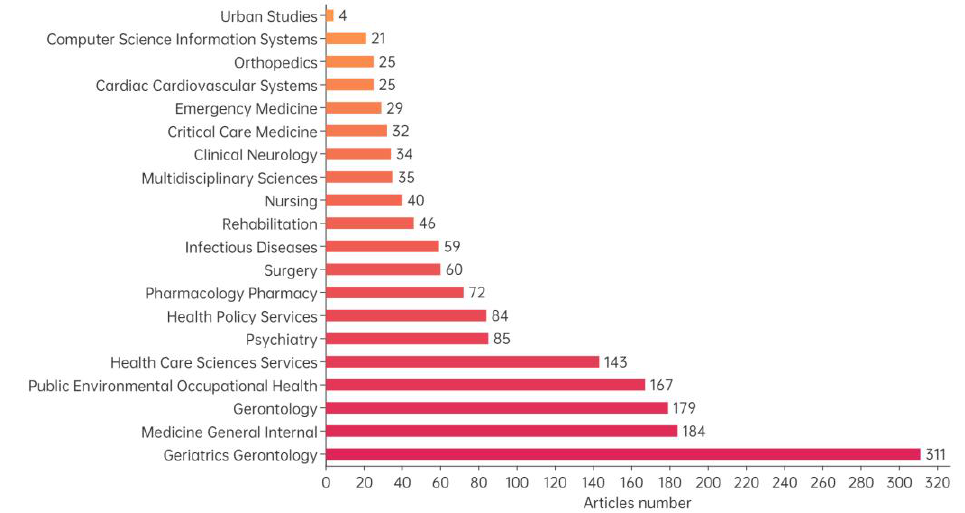
Figure 4. Distribution of FCMNCE research disciplines (top 20).